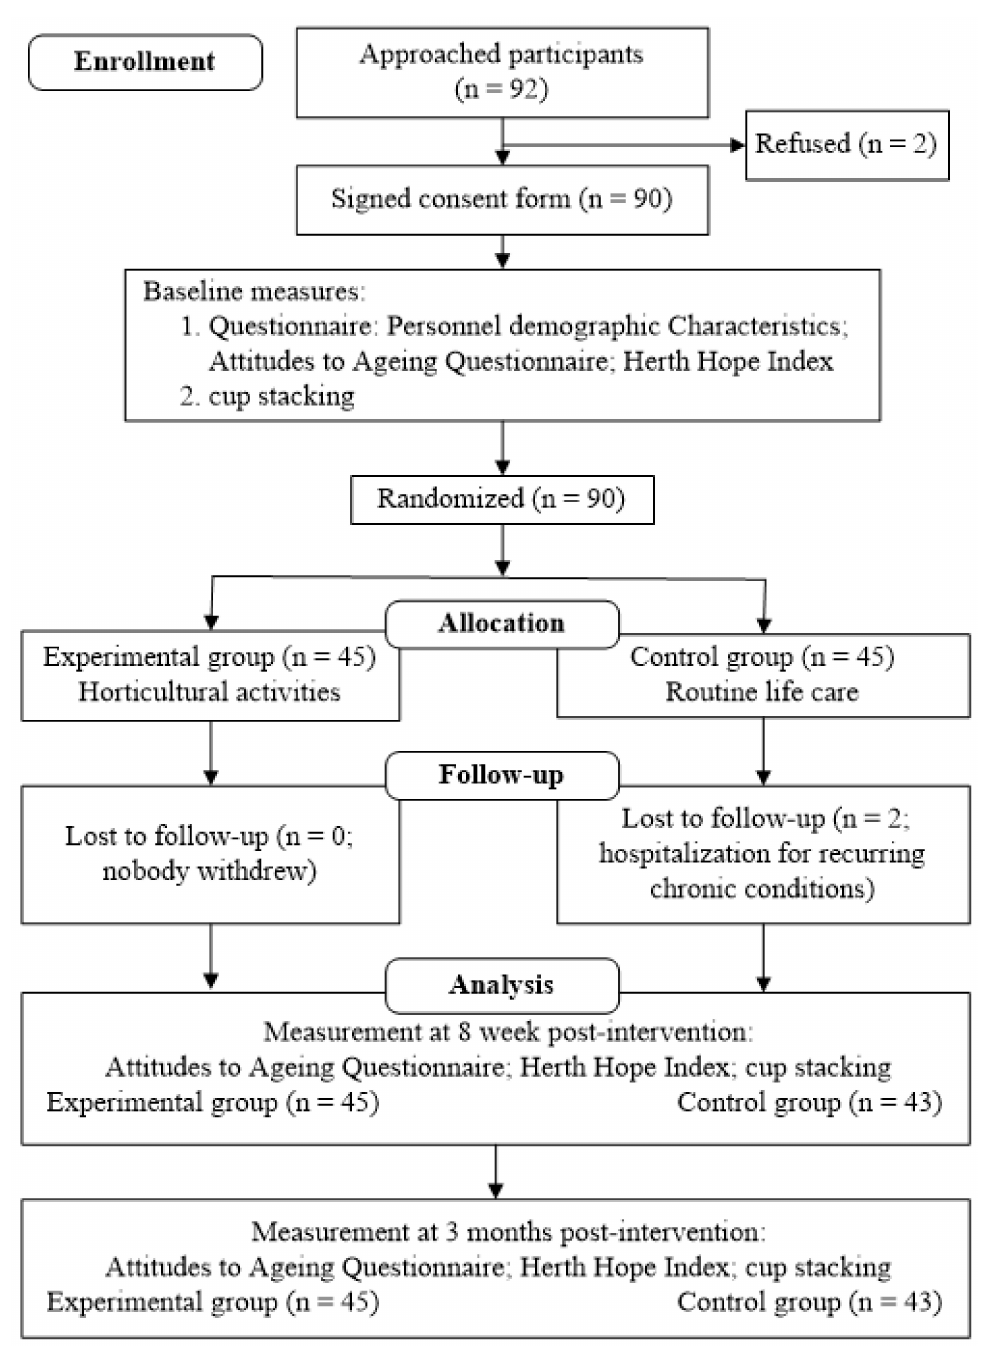
Figure 1. Flowchart of procedures for recruiting participants, implementing the intervention, and administering the Attitudes to Ageing Questionnaire, Herth Hope Index, and cup stacking